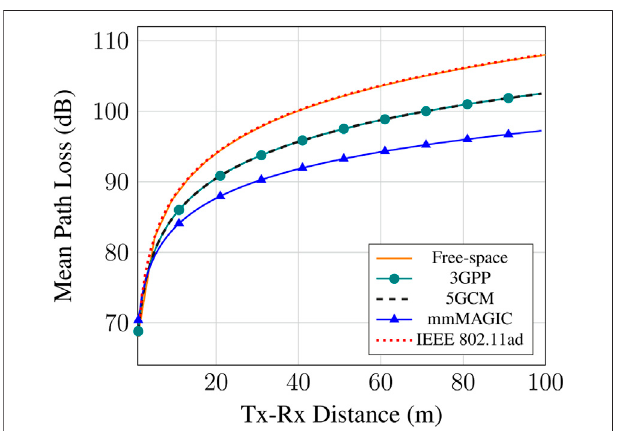
FIGURE 6 | Path loss versus Tx-Rx distance comparison among fi ve different channel models in LOS InH of fi ce scenario.